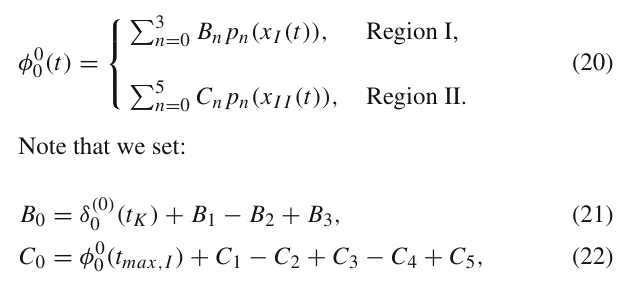
Fig. 4 Upper panel: modulus of the scalar-isoscalar ππ → K ¯ K scat- tering.ThecontinuouslinerepresentstheUFD C parameterizationwhile the dashed line represents the UFD B fit to the Brookhaven-II data only. Lower panel: scalar-isoscalar UFD phase for ππ → K ¯ K scattering,